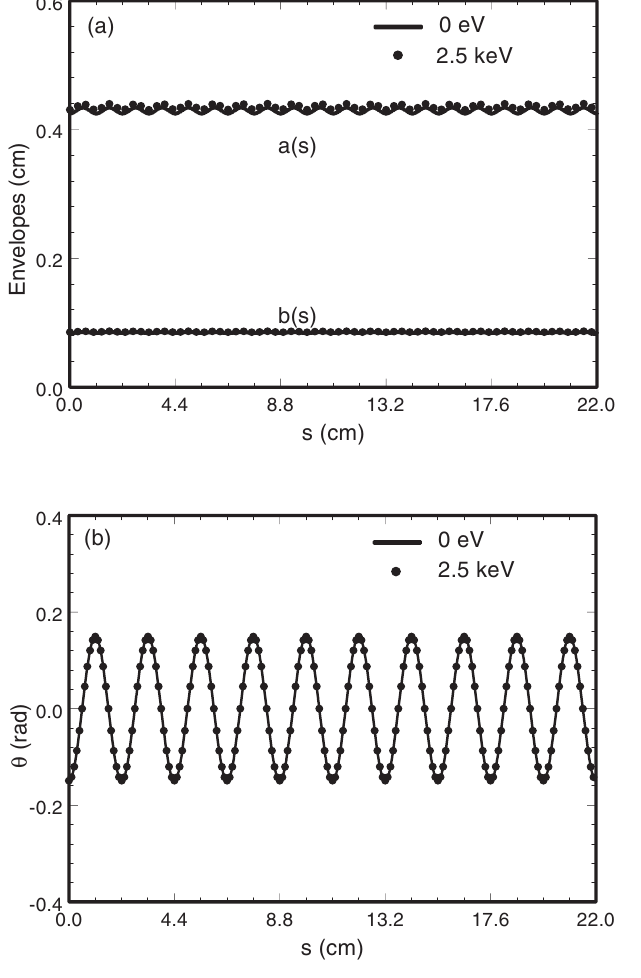
FIG. 4. Plots of (a) envelopes a (cid:3) s (cid:4) and b (cid:3) s (cid:4) and (b) twist angle (cid:3) (cid:3) s (cid:4) versus the axial distance s for the relativistic twisted elliptic beam. The solid curves are the generalized envelope solution for a zero-temperature beam, whereas the dotted curves are for a 2.5 keV on-axis temperature